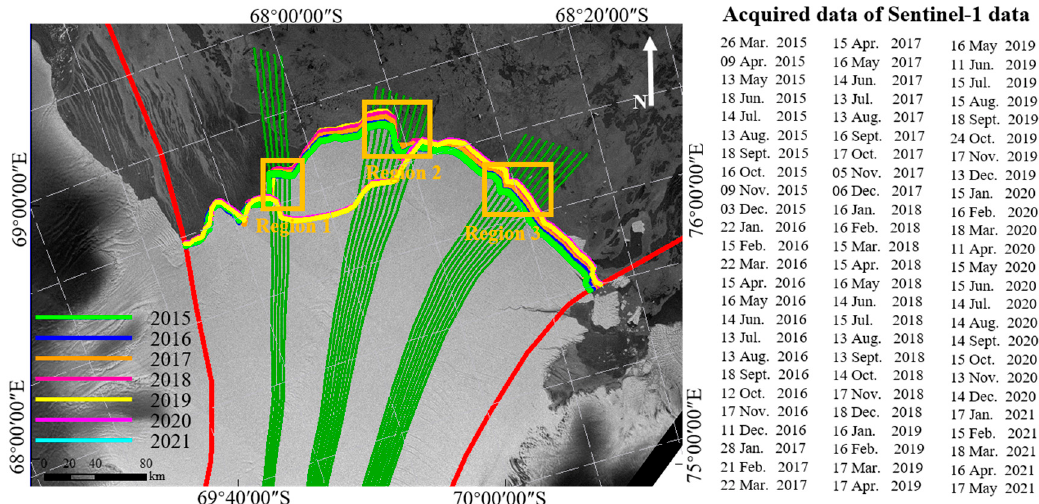
Figure 4. Research area and data set used in this study. The general trend of ice frontal position between 2015 and 2021 for Amery Ice Shelf. The colors indicate the time difference. We defined three regions for dynamical and seasonal analysis. The right panel is the data used for the spatio-temporal analysis. The background is from single-polarized Sentinel-1 data accessed on 26 March 2015.